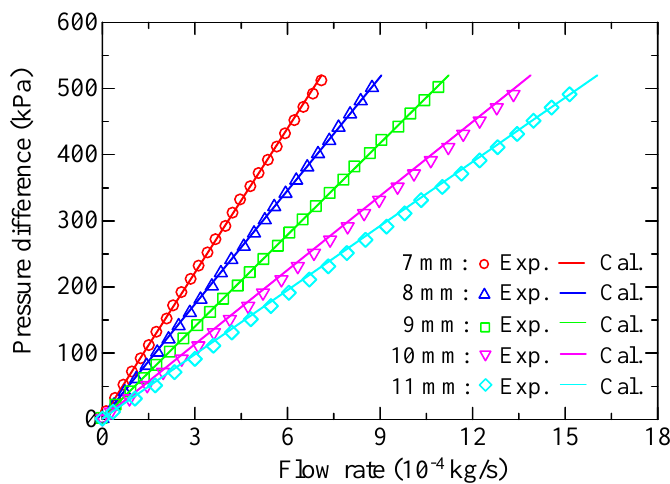
Figure 12. Comparison of the theoretical and experimental flow rate characteristics for the five porous media of group 2. Table 5. Deviations from the experimental data by the steady-state method and the discharge method.